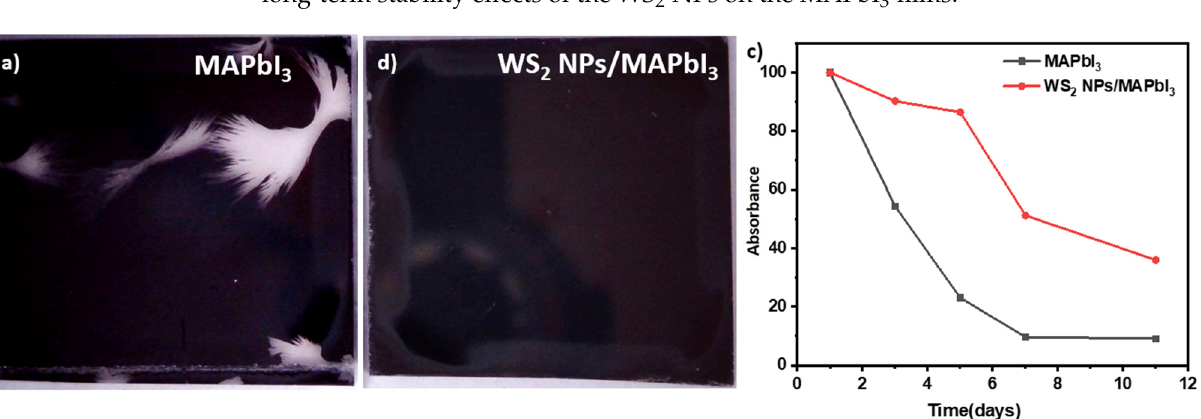
Figure 4. ( a ) MAPbI 3 and ( b ) WS 2 NPs/MAPbI 3 layers on top of the FTO glass substrate after expo- sure to air, ( c ) stability measurement of the samples: the absorption percentage of the hybrid WS 2 NPs/MAPbI 3 (red line) and the pristine MAPbI 3 (black line). WS 2 NPs/MAPbI 3 (red line) and the pristine MAPbI 3 (black